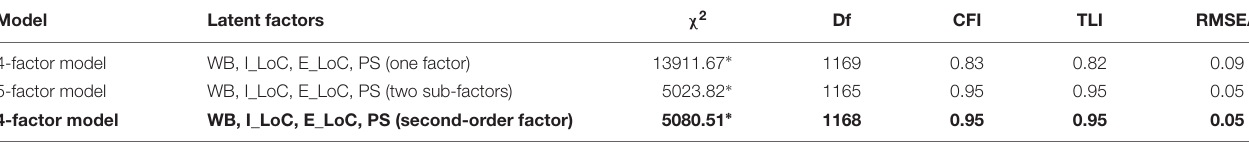
TABLE 2 | Fit statistics for confirmatory factor analysis ( N = 1474).